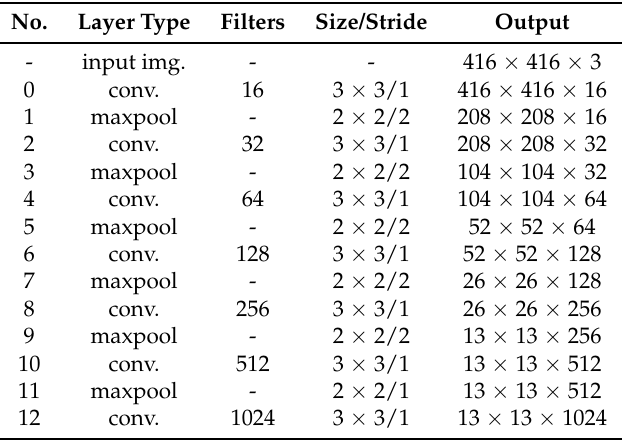
Table 1. Description of YOLOv3-tiny